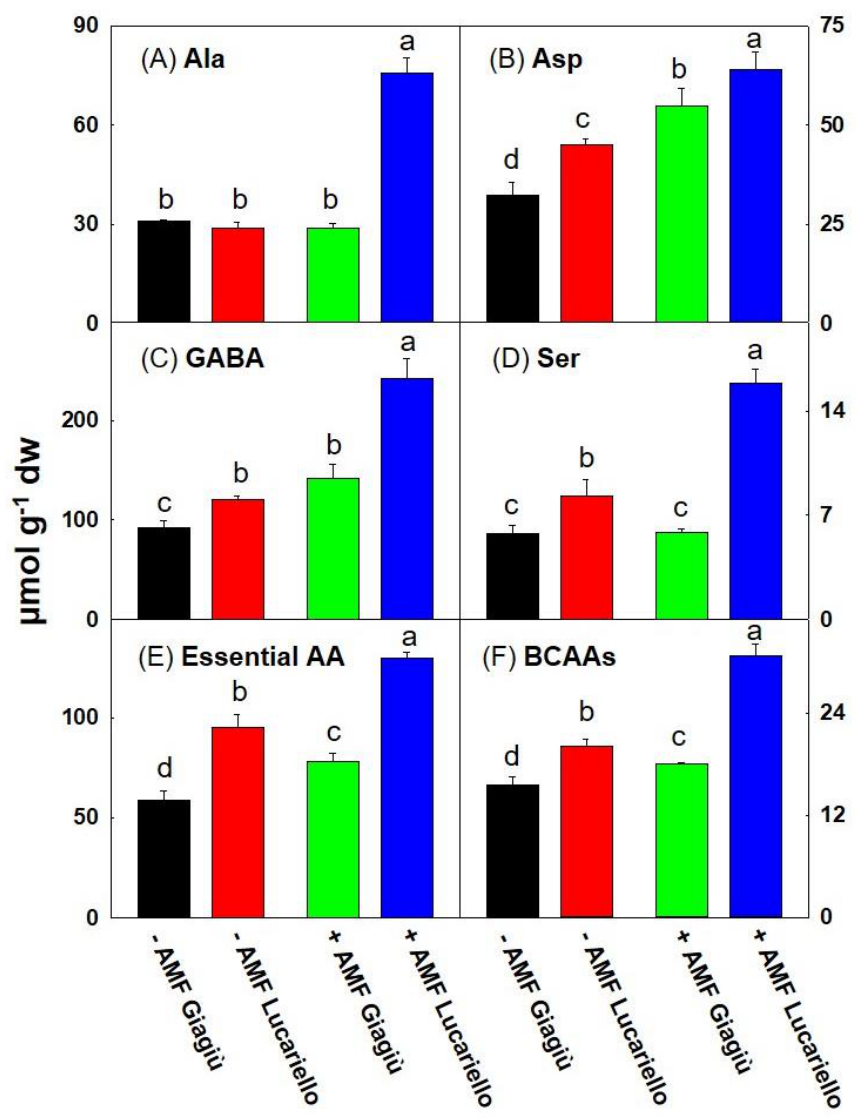
Figure 3. Effects of arbuscular mycorrhizal fungi (AMF) on alanine ( A ), aspartate ( B ), GABA ( C ), serine ( D ), essential amino acids ( E ) and branched-chain amino acids (BCAAs) ( F ) of yellow-pigmented type (‘Giagiù’) and red-pigmented type (‘Lucariello’) landraces of ‘Pomodorino del Piennolo del Vesuvio’ (PPV) cultivated in the Campania region under rainfed conditions. Values are the means of three replicates ± SD. Different letters indicate significant differences according to Duncan’s test ( p = 0.05).